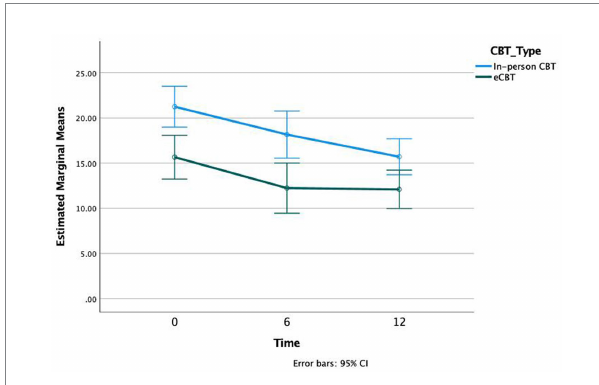
FIGURE 2 Patient Health Questionnaire (PHQ-9) scores at three time intervals of treatment, Weeks 0, 6, and 12, in both in-person and online cognitive behavioral therapy (e-CBT) treatment conditions.